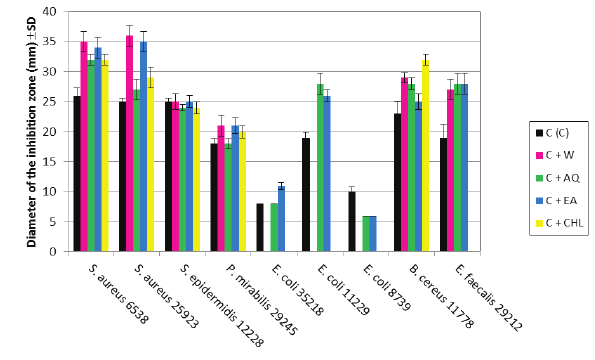
Figure 6: Bacterial strains response to Chloramphenicol/C combinations with the four Arctii folium extracts (C+W, C+AQ, C+EA, and C+CHL) comparatively to the antibiotic alone, C (C); diameter of the inhibition zone, (mm) ± SD.